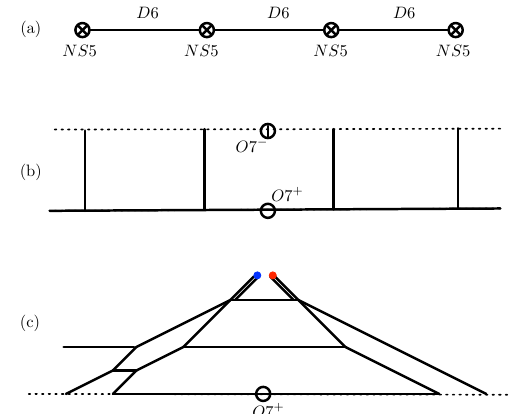
Figure 11. (a) Type IIA configuration for 6d SU(1) − SU(1) − SU(1) theory or equivalently SU(4) theory. (b) A Z 2 twisted compactification of (a), where 1/2 D 5 -branes are stuck along the cut of an O 7 + -plane. (c) Type IIB 5-brane configuration after resolving an O 7 − into two 7-branes of